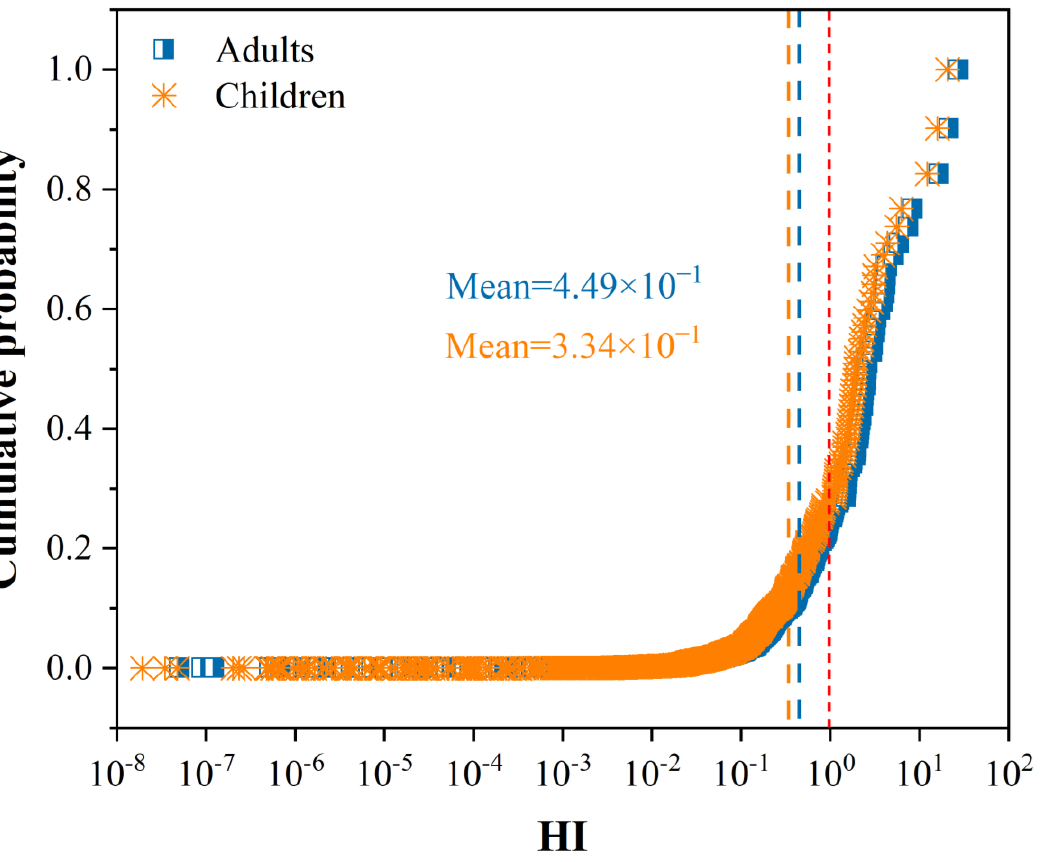
Figure 6. Cumulative probabilities of different population groups’ non-carcinogenic risk of Sb exposure in soils.